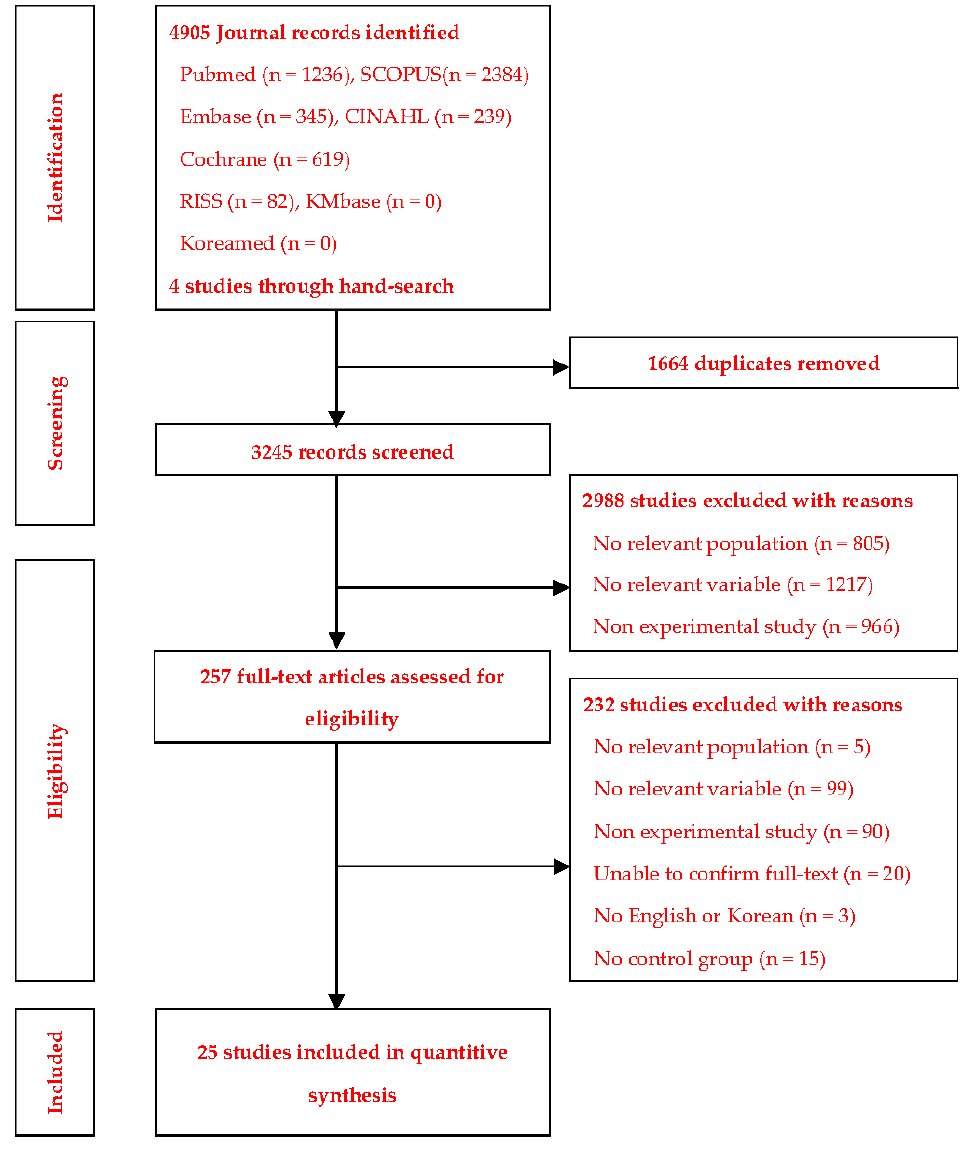
Figure 1. Study extraction process.